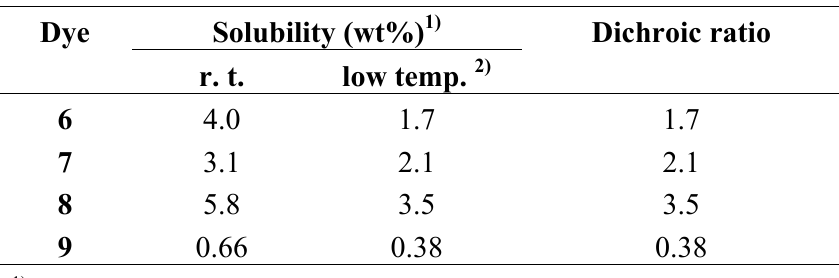
Table 2. The relationships between molecular structures of yellow anthraquinone dyes and their solubilities and dichroic